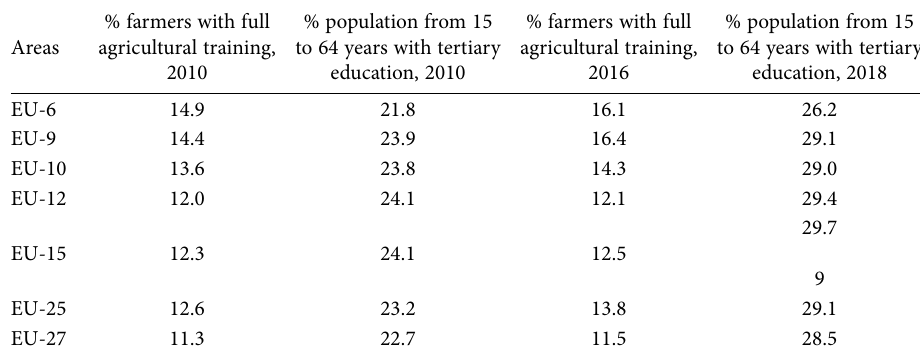
Table 1. Human capital in EU agriculture and economy, 2010 and latest available years.